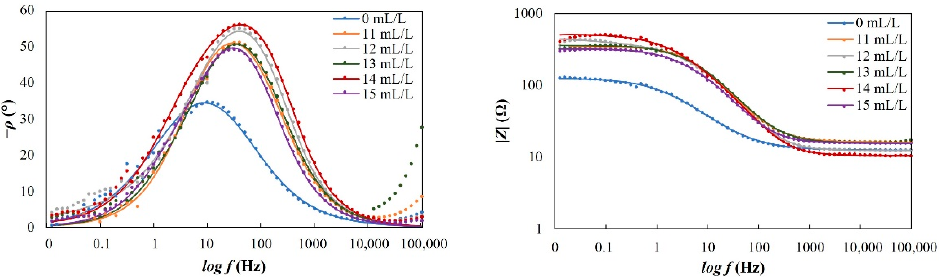
Figure 7. Nyquist plot scanned on the carbon ‐ steel sample in the simulated brine saturated with CO 2 with and without the inhibitor in flow conditions (Adapted from [24]).